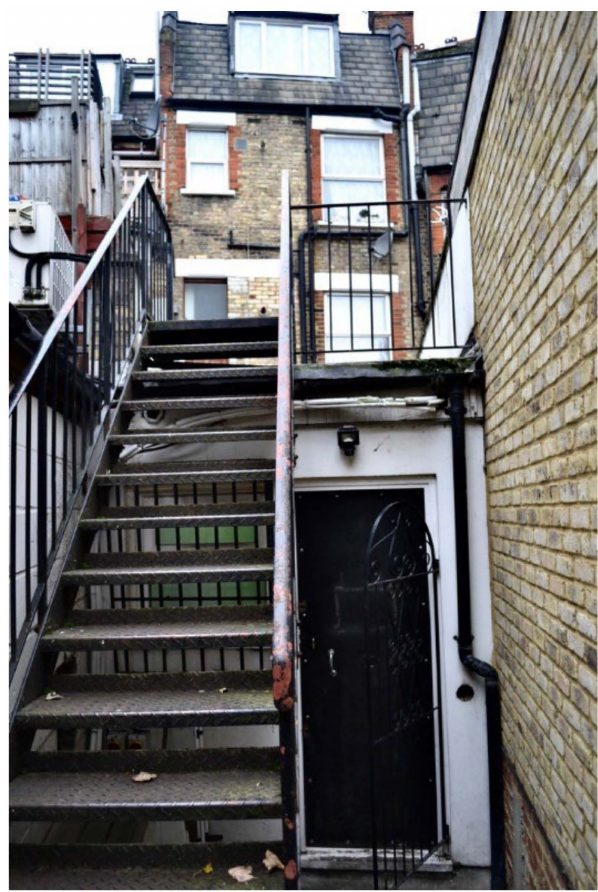
Figure 24. House visit.